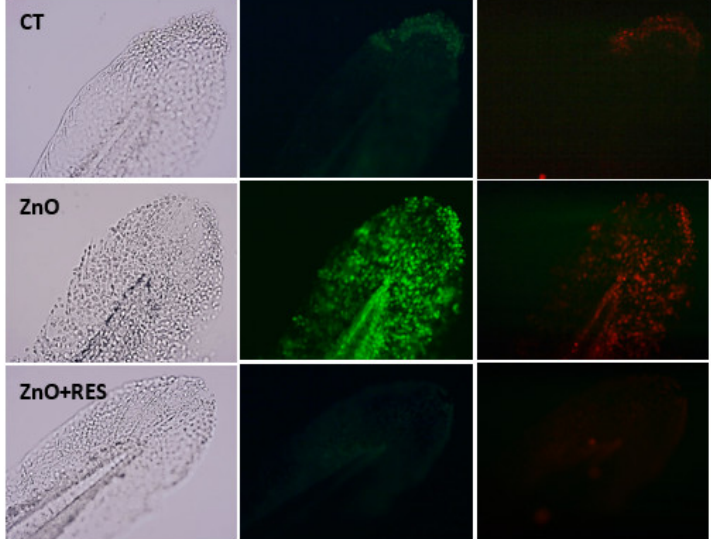
Figure 7. Resveratrol counteracts ZnO NP-induced apoptotic and necrotic fluorescence signals. Fluorescent microscopy images of AO/PI double staining in zebrafish untreated embryos (CT), 3 mg/L ZnO-treated embryos (ZnO NP), and 3 mg/L ZnO + 5 μM resveratrol treated embryos (ZnO + RES). As compared to untreated embryos, ZnO NP-treated zebrafish embryos emit a strong green and red fluorescence signal evidence of increased apoptosis and necrosis, a phenomenon prevented by resveratrol treatment. RES, resveratrol. Magnification 20×.